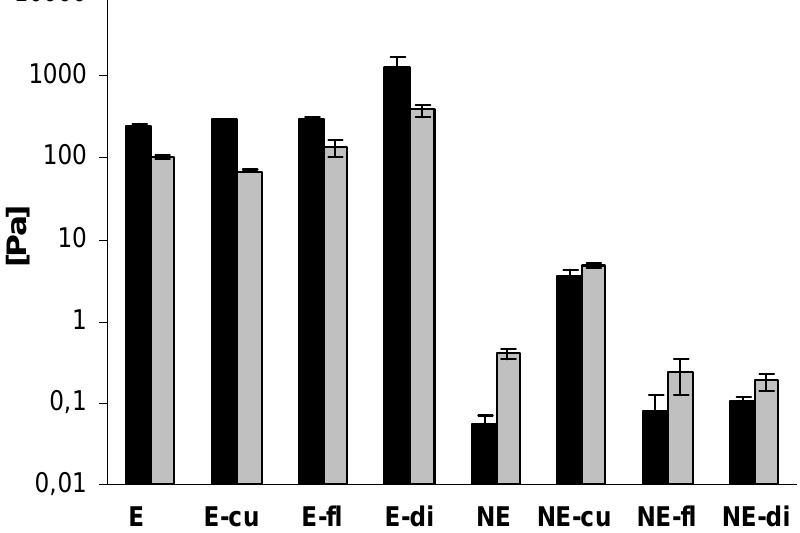
Figure 8. Comparison of the elastic modulus G’ (black bars) and the viscous modulus G’’ (grey bars) of macroemulsions (E) and corresponding nanoemulsions (NE) with and without incorporated drug at an oscillatory frequency of 1 Hz. The effect of the incorporated drugs curcumin (cu), flufenamic acid (fl) and diclofenac acid (di) is demonstrated. Values represent the mean of three formulations (n = 3) and are given ±